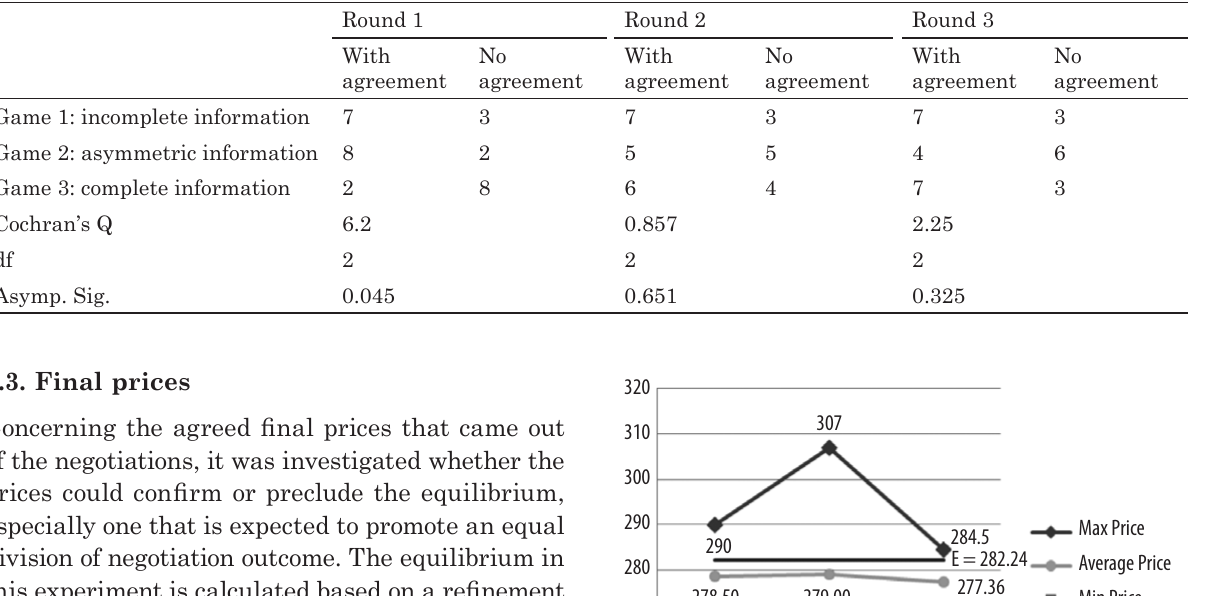
Table 3. Cochran’s Q test results